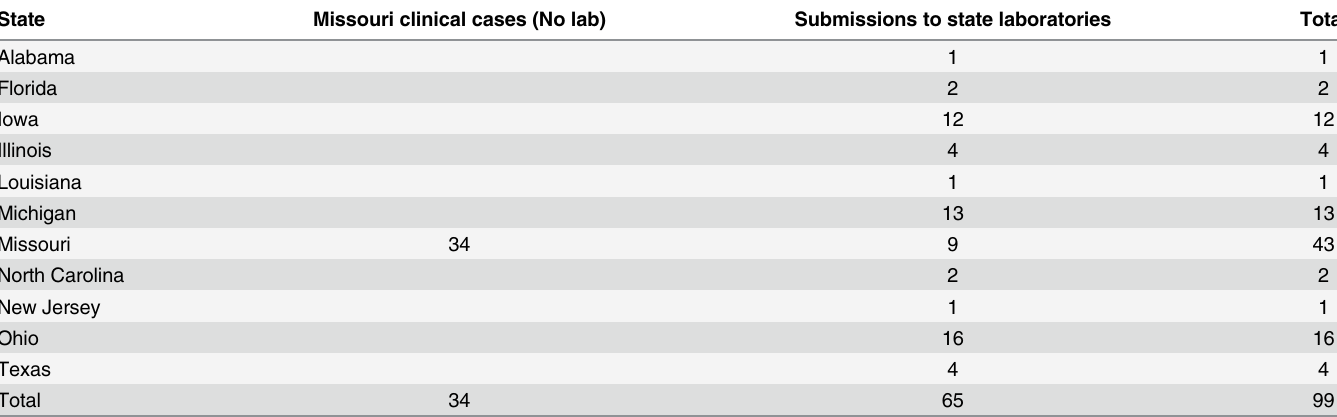
Table 3. EHD cases in white-tailed deer from June 1 to December 31, 2012.